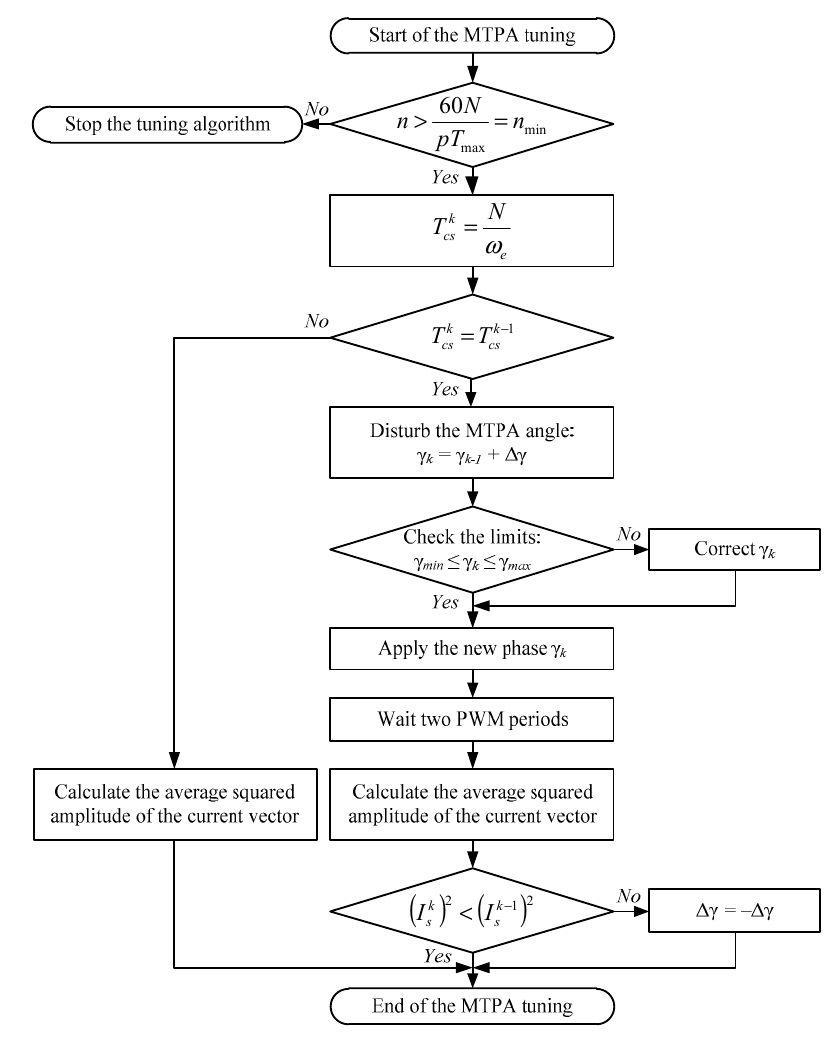
Figure 4. Flowchart of the proposed algorithm.